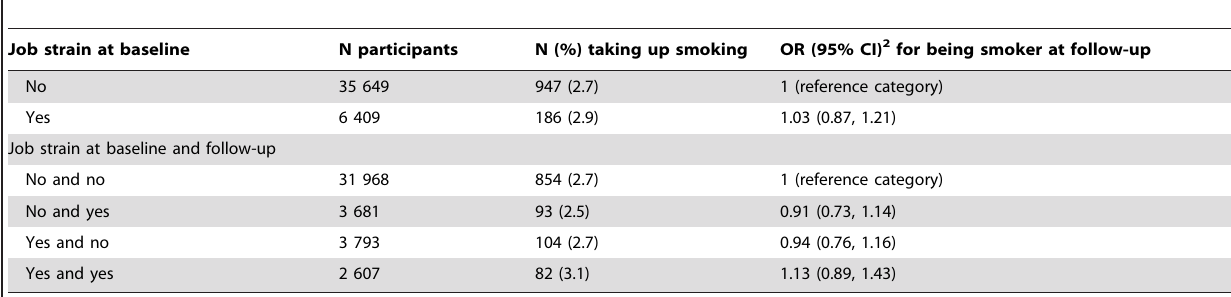
Table 3. Longitudinal associations between job strain and taking up smoking among baseline never- and ex-smokers (n= 42 049) 1 .